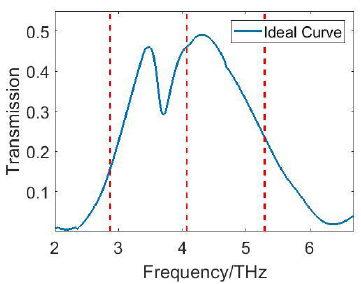
Figure 2. Optimal filtering effect.